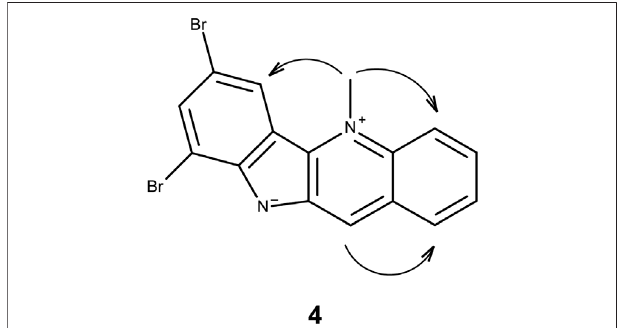
FIGURE 3 | NOE correlations in 4